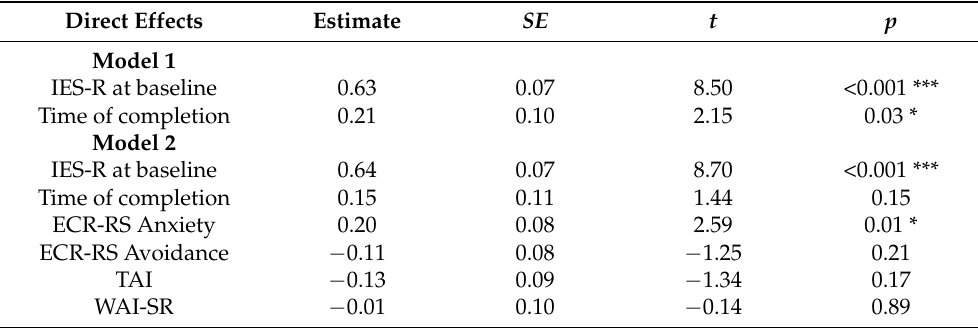
Table 3. Standardized Regression Coefficients for Multiple Linear Regression Models for IES-RS at Follow-up.